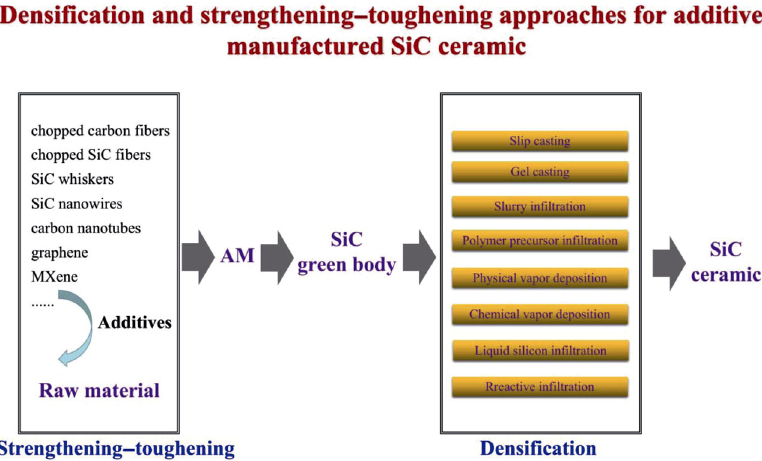
Fig. 36 Densification and strengthening–toughening approaches for additive manufactured SiC